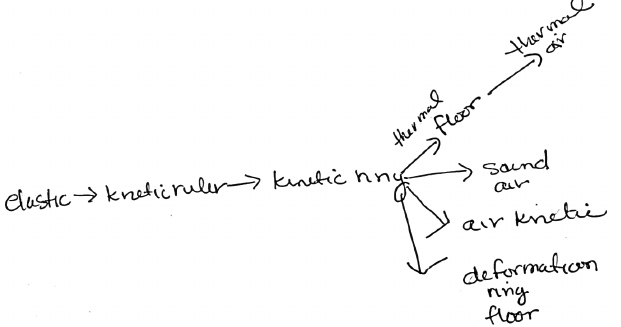
FIG. 6. A learner-invented “ energy trajectory ” diagram for a ring slider scenario.